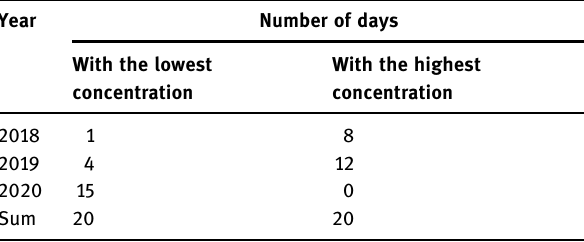
Table 1: Summary of 20 days with the lowest and highest average daily concentration of NO x in the air in Krakow ( on Krasinskiego Avenue ) , broken down by year